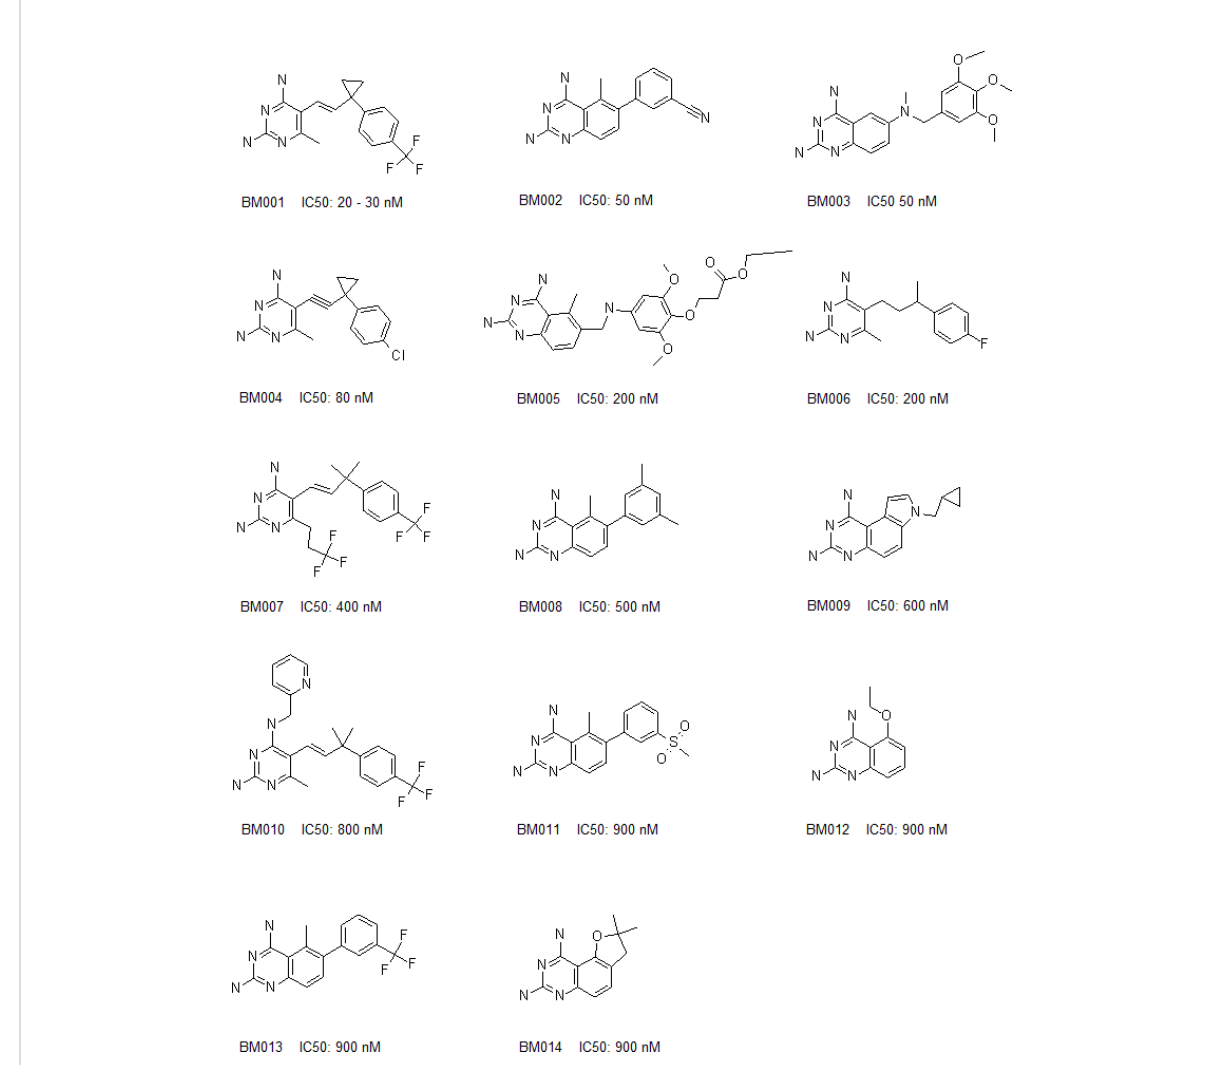
FIGURE 4 Chemical structures, ranked according their inhibitory effects on GHR signaling and/or cell